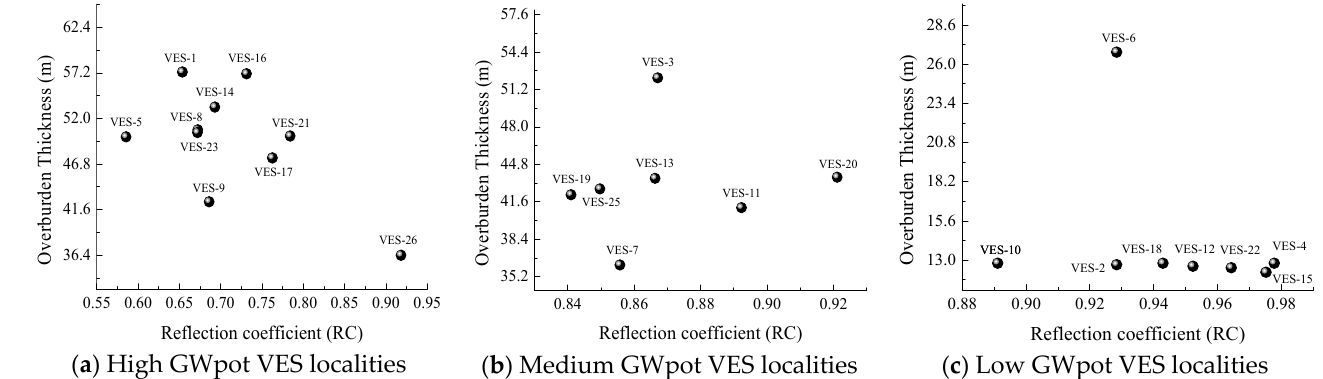
Figure 15. Groundwater potential VES distribution corresponding overburden thickness and reflection coefficient (RC): ( a ) high yield GW pot VES stations, ( b ) medium yield GW pot VES stations, and ( c ) low yield GW pot VES